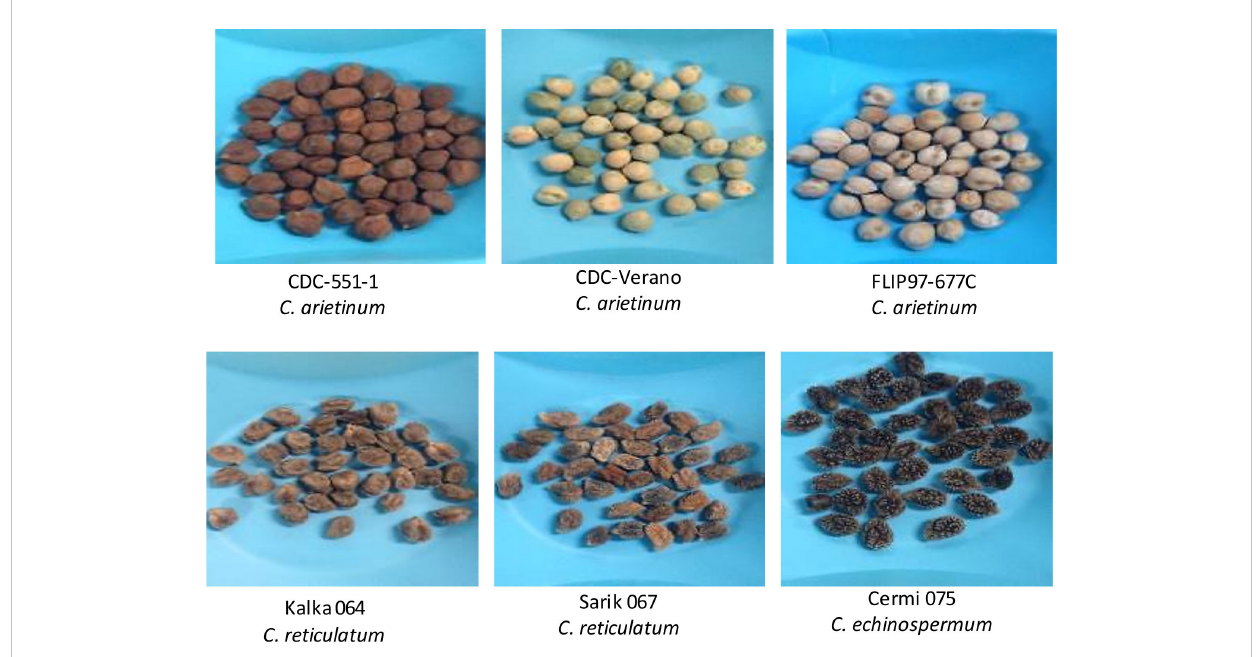
FIGURE 1 Six diverse chickpea genotypes used for the study of Fe absorption and accumulation in the